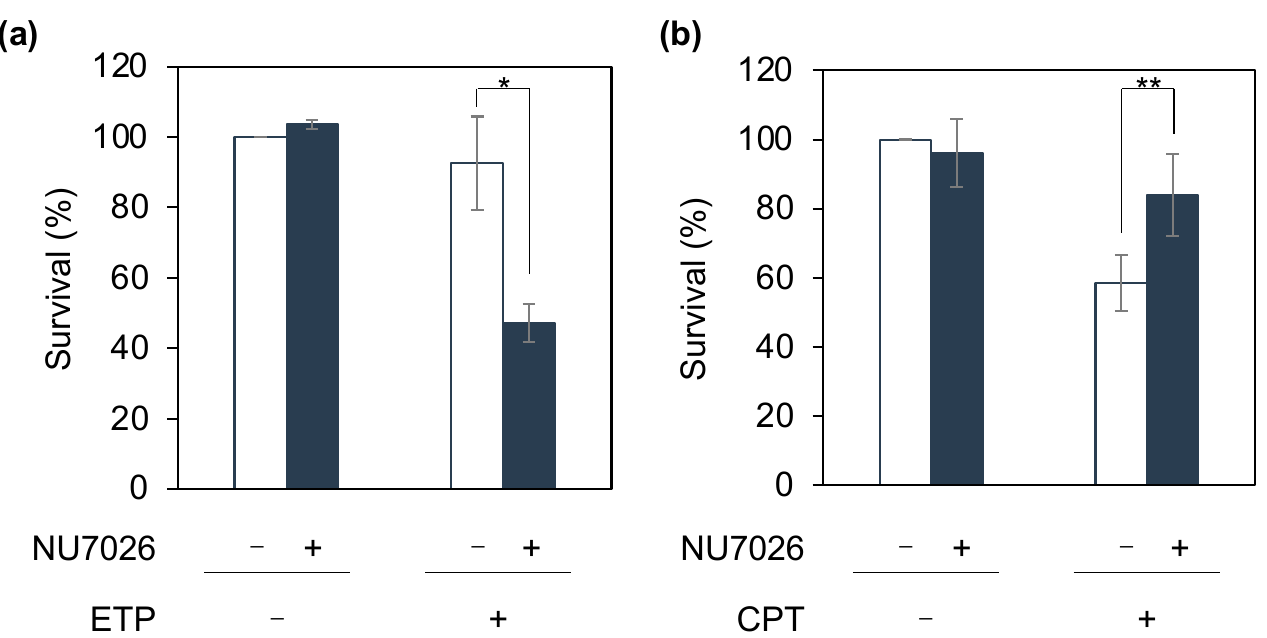
Figure 3. Sensitivity assay with the DNA-dependent protein kinase inhibitor, NU7026. HeLa cells were pretreated with NU7026 for 1 h prior to treatment with 50 nM etoposide (ETP, ( a )) or 13 nM camptothecin (CPT, ( b )). The cells were cultured for 13–14 days, and the resulting colonies were stained with crystal violet and counted. Data are presented as the mean ± standard deviation of three independent experiments. Data represent the mean ± standard deviation of at least three independent experiments (Student’s t -test; * p = 0.0054, ** p = 0.007). Where absent, error bars fall within the symbols.